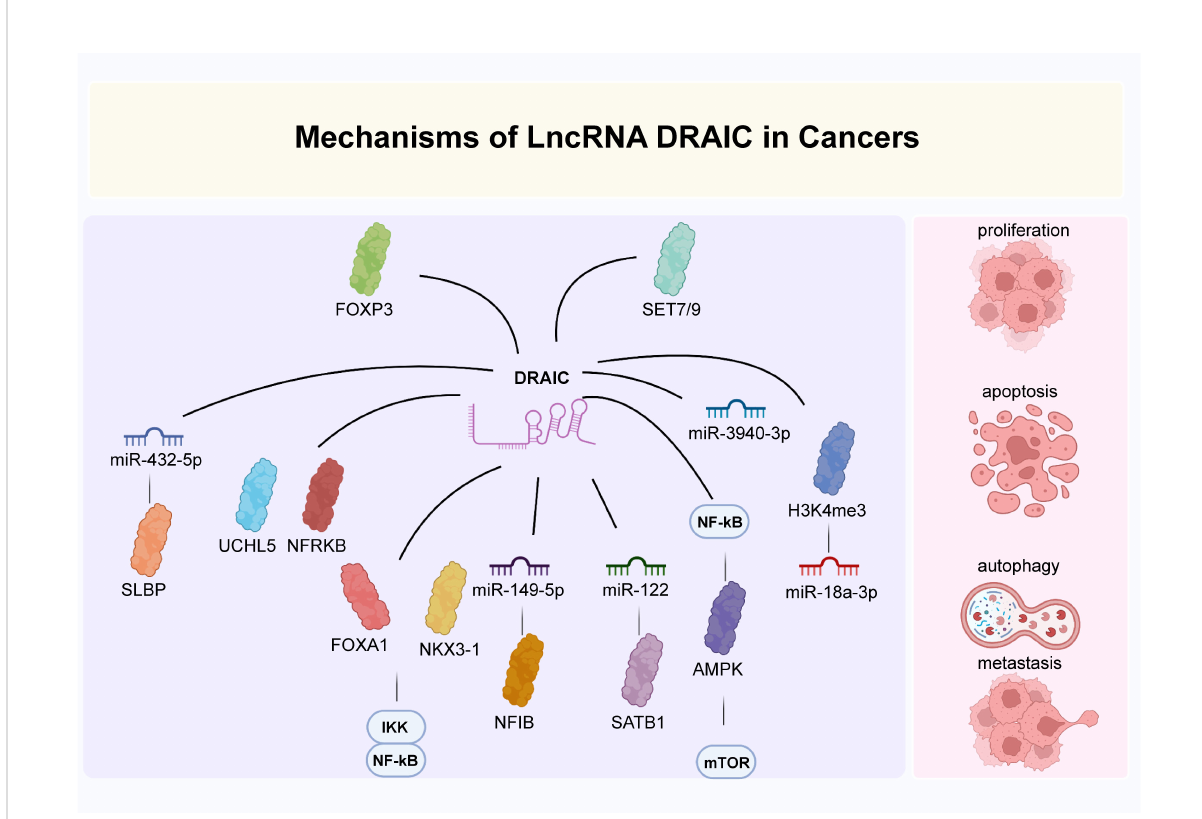
FIGURE 4 The main mechanisms of DRAIC in cancers. DRAIC participated in the regulation of biological processes of cancers through interaction with diverse